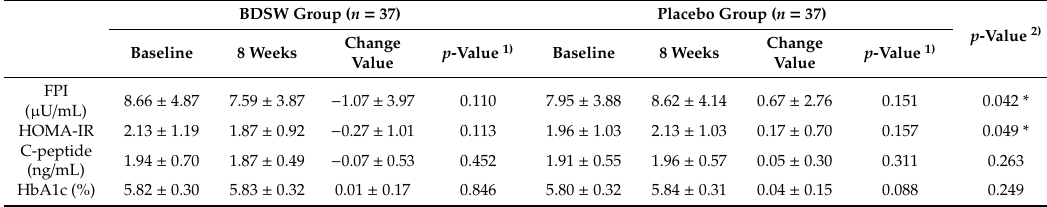
Table 5. Changes in blood glucose-related indicators before and after ingestion.